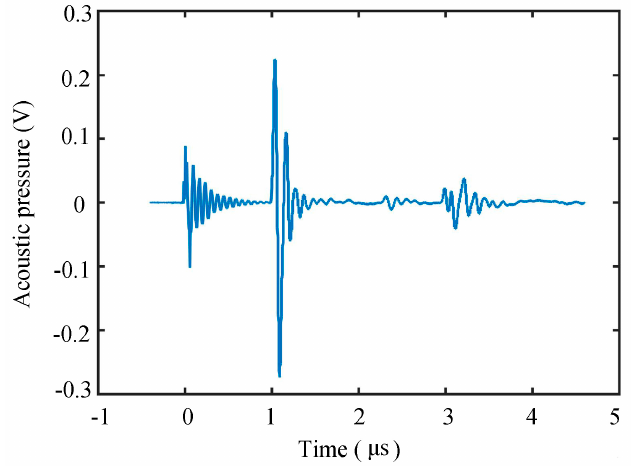
µ m beam-forming